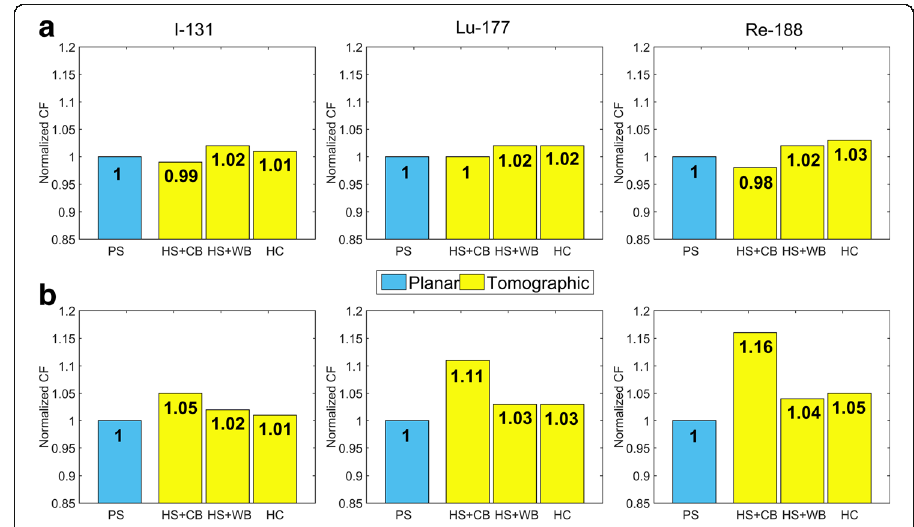
Fig. 4 Summary of CF obtained from simulated phantom experiments performed using different phantom configurations. a shows CFs obtained from primary photons only normalized using CF PPsim , while CFs shown in b were calculated using total counts recorded in the photopeak window corrected for scatter with TEW and normalized using CF PWSCsim Simulated spectra presented in Fig. 5 correspond to the phantom configuration B (HS + CB). The graphs compare the shapes of the photopeak, the true scatter compo- nent observed in PW and the scatter estimated by the TEW method using counts recorded in LSW + USW. Counts in the three regions were analyzed. Spectra presented in Fig. 5b correspond to counts recorded in the source ROI, and Fig. 5a shows the loca- tion of the source ROI drawn in the projection images of each isotope. Spectra in Fig. 5c correspond to counts recorded in the background region around the source, and Fig. 5d